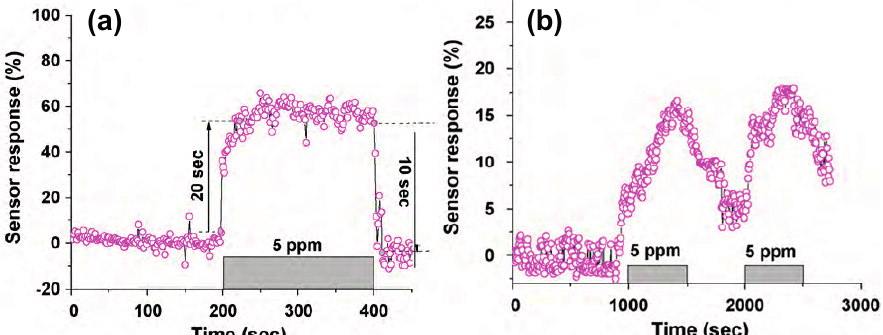
Figure 8. ( a ) Sensor response plot of the Zn-In 5 ppm CO gas; ( b ) Response plot for the undoped In 5 ppm CO gas in two cycles